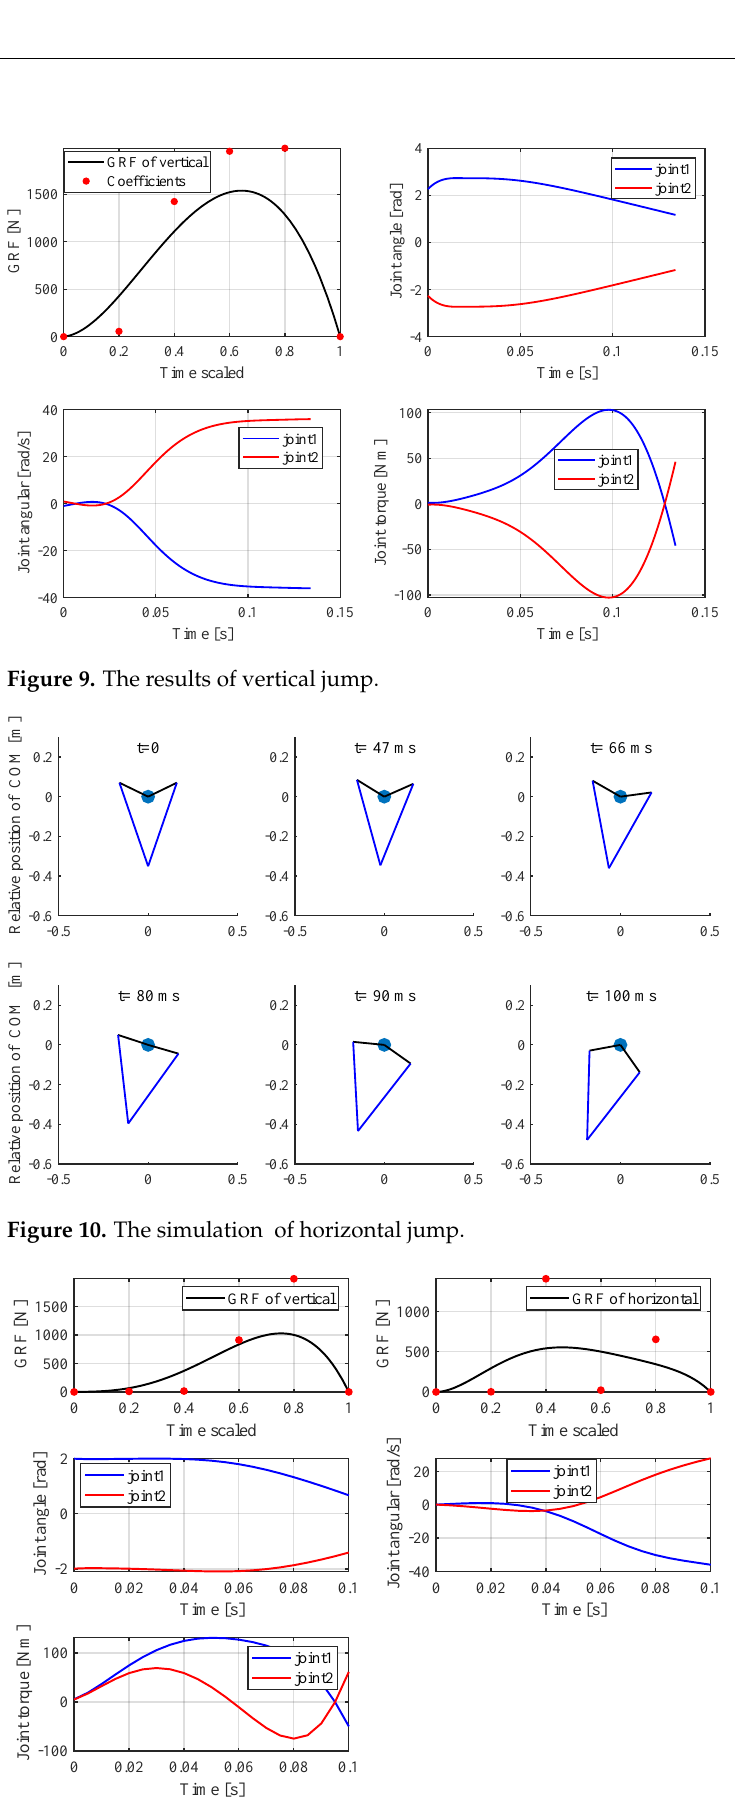
Figure 11. The simulation results of horizontal